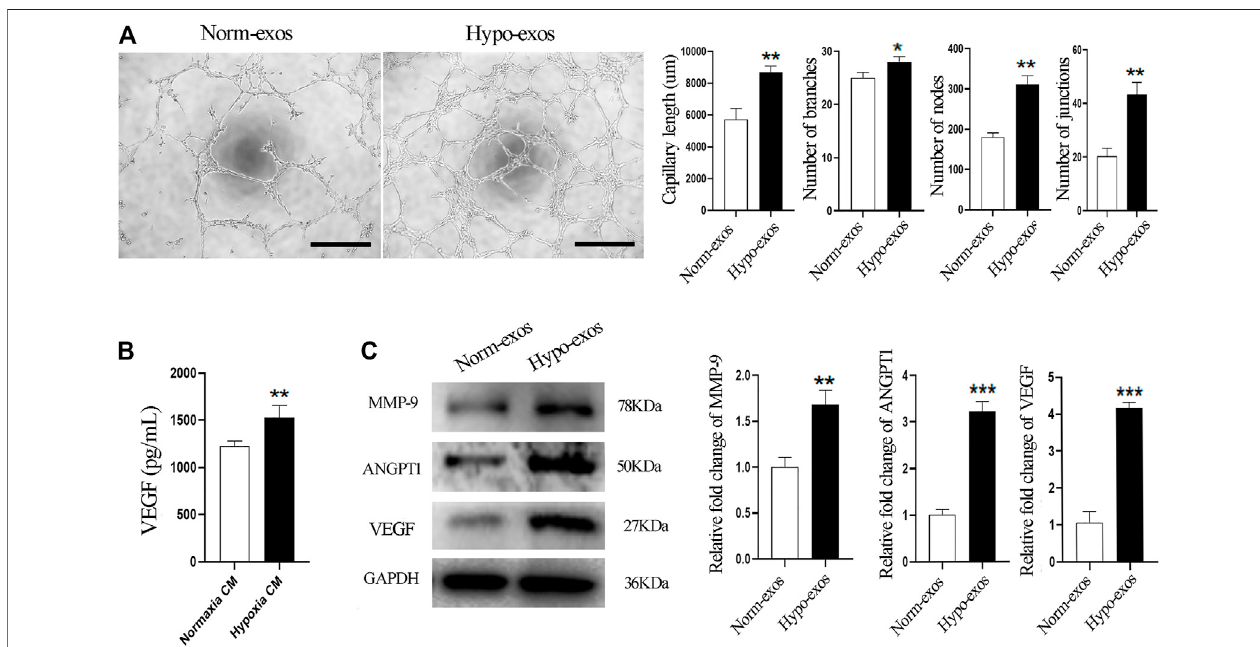
FIGURE3 | Hypo-exos signi fi cantly enhance the tube formation ofendothelialcells invitro . (A) Signi fi cantlyenhanced effect inthe Hypo-exos treated group on the formation of network structures by HUVECs shown by tube formation assays (left) and the formed capillary-like structures in two groups were quantitated (right); scale bars = 500 μ m. (B) Secretory VEGF levels at 48 h were increased signi fi cantly in hypoxic conditioned medium as detected by ELISA. (C) Protein expression levels of MMP-9, ANGPT1 and VEGF were enhanced markedly as shown by western blot analysis (left) and relative levels were quali fi ed as relative fold change to the respective Norm-exos treated cells (right). * p < 0.05, ** p < 0.01, *** p < 0.001.